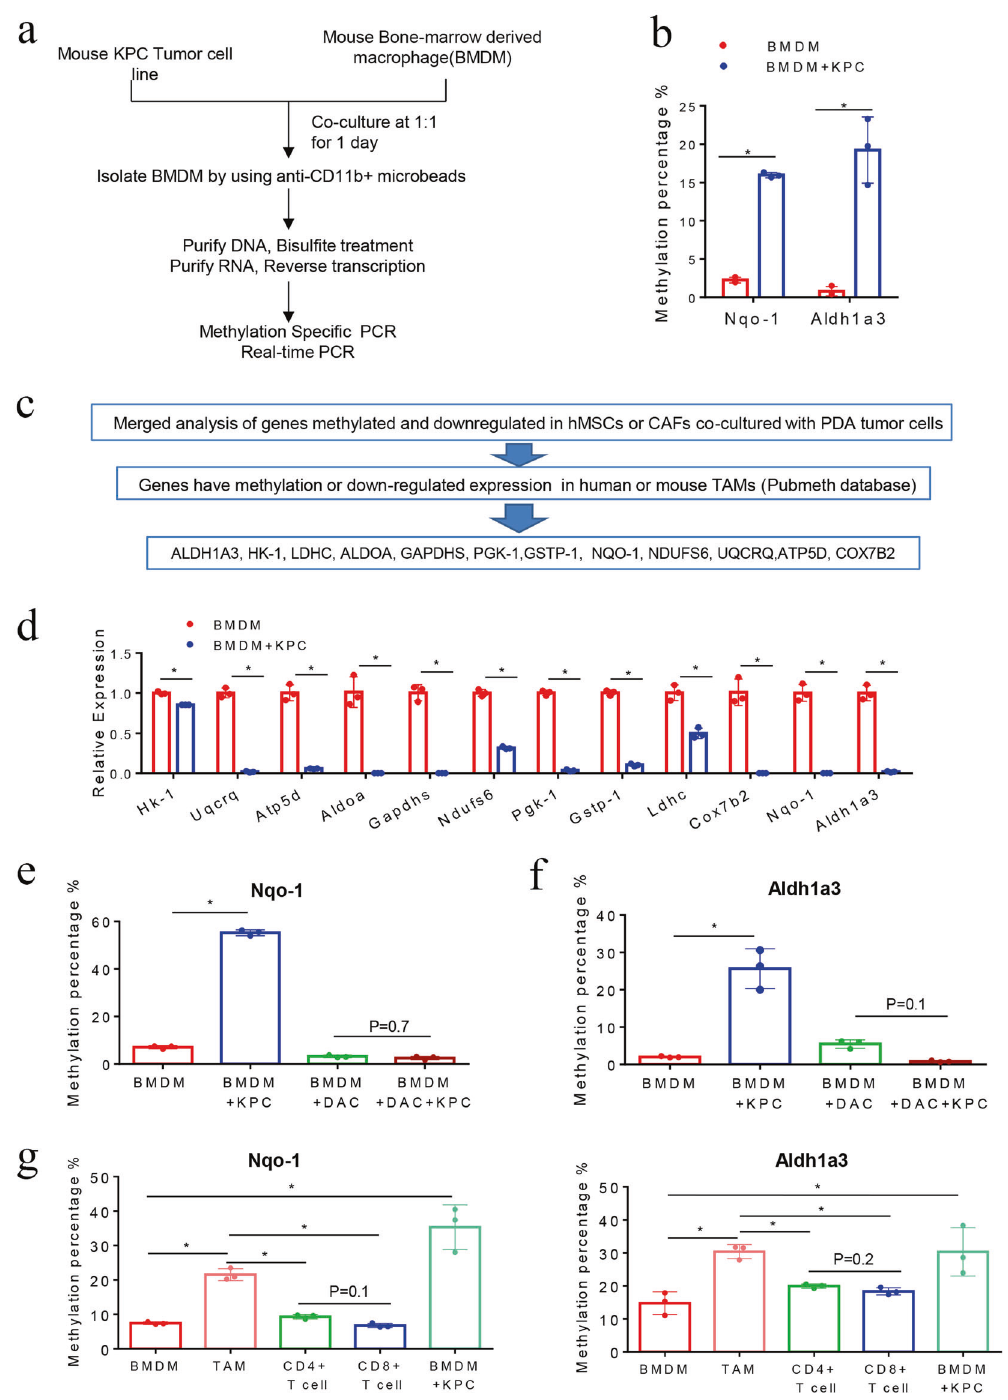
Fig. 1 PDA cells reprogram macrophages in TME through DNA methylation. a Tumor and macrophage co-culture experimental schema. b Nqo-1 and Aldh1a3 methylation was examined by methylation-speci fi c PCR (MSP) in mouse BMDMs after co-culturing with KPC PDA cells. * P <0.05 (paired t test). c The schema of the candidate gene selection process. d Expression of the key genes in glucose metabolism and OXPHOS pathway in mouse BMDMs after co-culturing with KPC cells. The mRNA expression of these genes was measured by RT-PCR and β -actin was used for normalization. e , f Nqo - 1 and Aldh1a3 methylation after pretreating BMDMs with DAC. * P <0.05 ( d , e , f , Mann – Whitney U test) . g Methylation of Nqo - 1 and Aldh1a3 in TAMs, CD4 + and CD8 + T cells from primary PDA and BMDMs (consider as M0 macrophages) of the same KPC mice, and BMDMs after co-culturing with KPC cells. * P < 0.05 (ANOVA). Data are means ±SEM from technical duplicates and representative of two immuno fl uorescent staining of co-cultured PDA cells and macro- of co-culture (Fig. 2a, b). We further demonstrated that Lucifer phages, respectively, with their lineage markers (Pan-CK and F4/ Yellow can spread to macrophages from pre-stained PDA cells 80). In addition, PDA cells can be distinguished from macrophages after cell-to-cell interaction (Fig. 2c), supporting the direct contact according to the size of the nucleus. PDA cells and macrophages between PDA cells and macrophages. We also conducted the